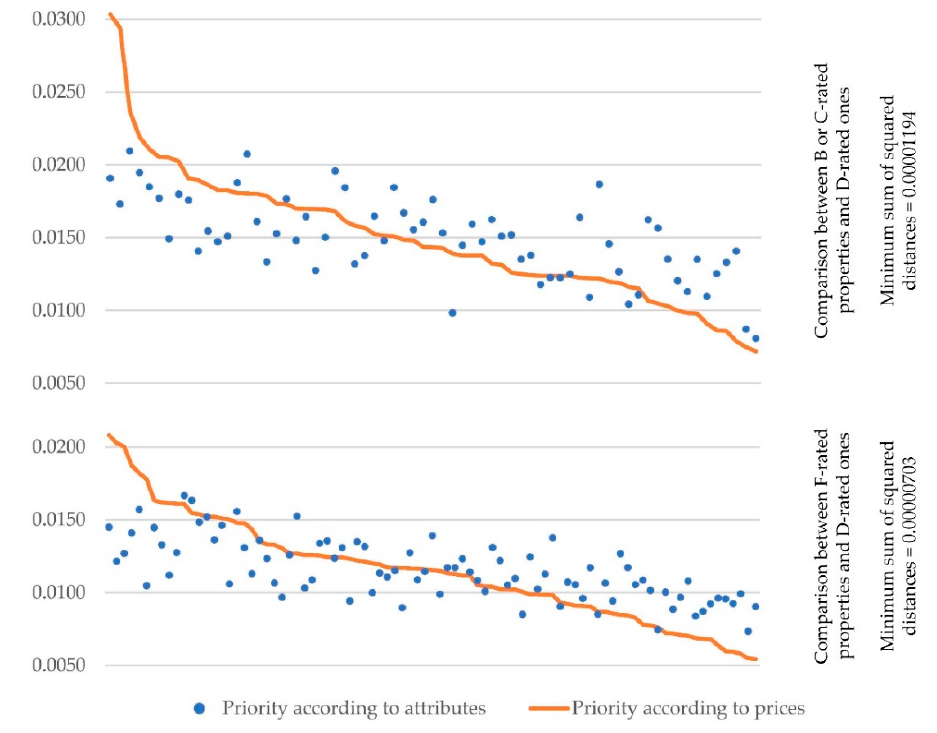
Figure 9. Comparison between the priorities identified according to the attribute values and according to the property prices in the multi-criteria model.